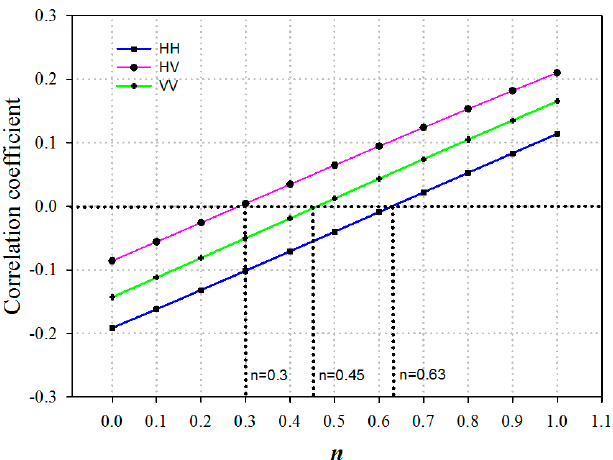
Figure 14 . Correlation coefficients between the AVE corrected backscattering values and local incidence angle for various values of n .